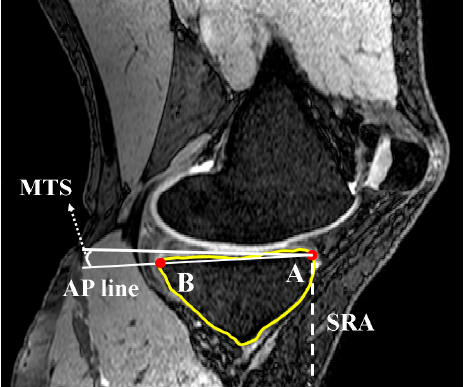
Figure 5. Measurement of posterior tibial slope as the angle between AP line and the SRA (sagittal view).